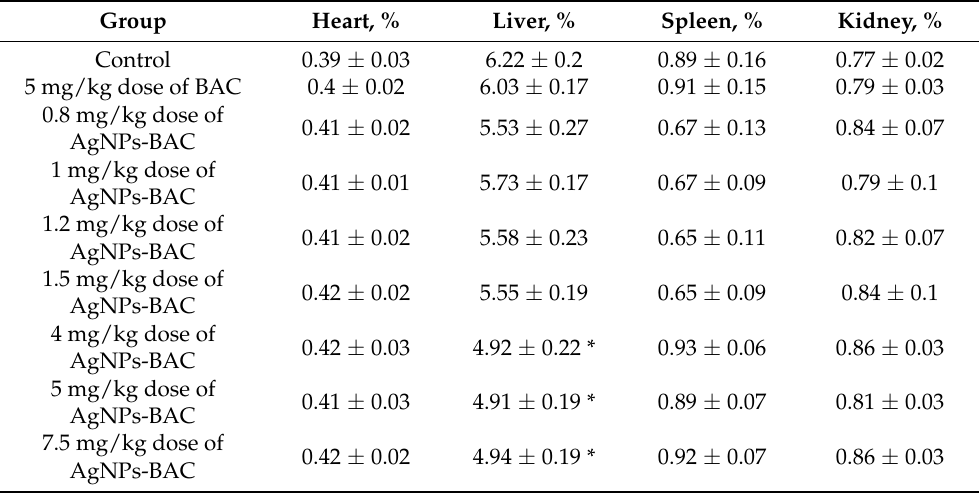
Table 2. The mass coefficients of the mice organs following single AgNPs-BAC administration. Group Heart, %